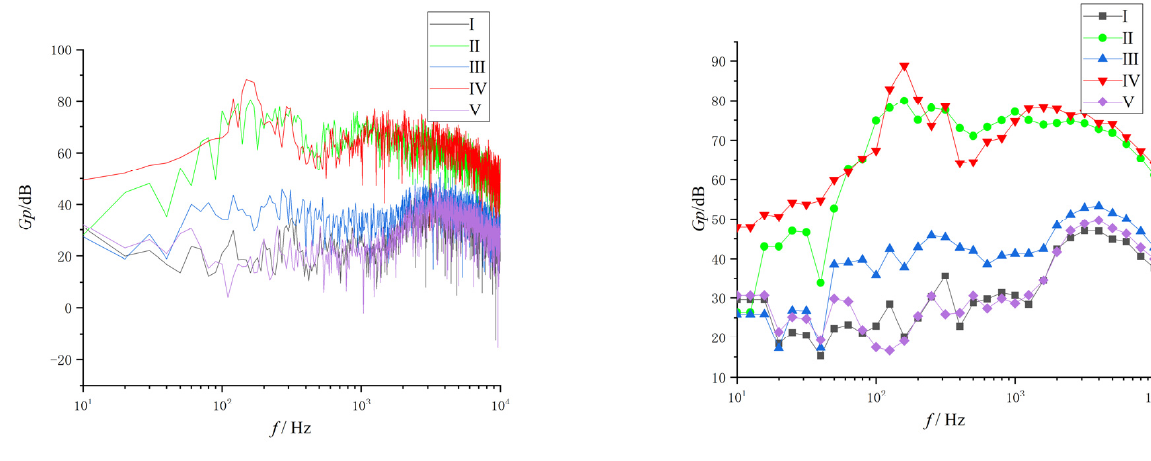
Figure 16. The self-power spectral of the pressure fluctuation at the velocity of 10 kn. (I) Re s = 2.275 × 10 5 , (II) Re s = 5.668 × 10 5 , (III) Re s = 7.939 × 10 5 , (IV) Re s = 1.136 × 10 6 , (V) Re s = 1.590 × 10 6 .